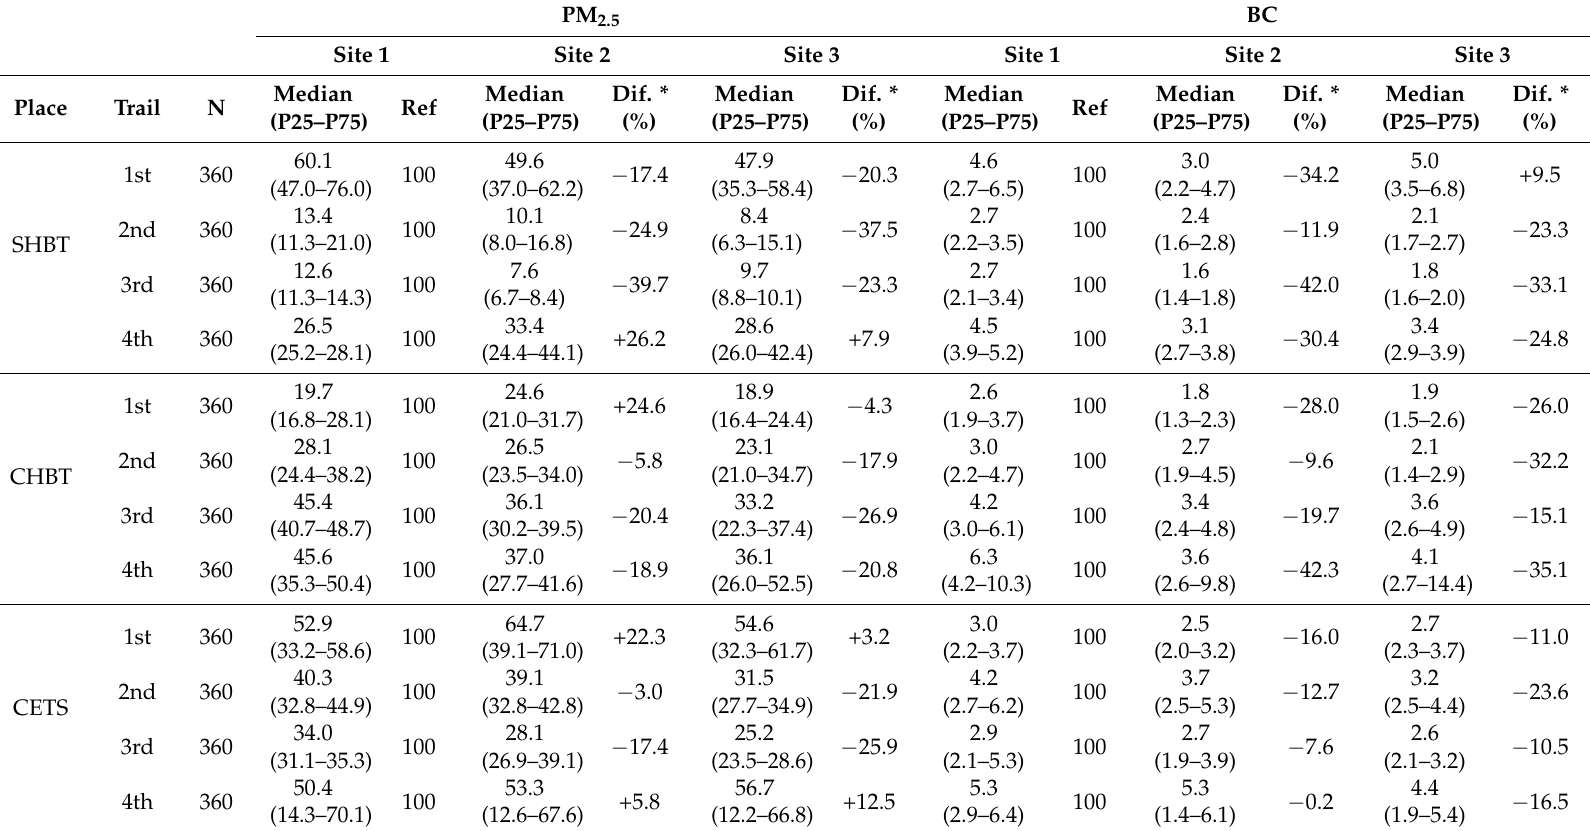
Table 1. Distributions of PM 2.5 and black carbon (BC) concentrations (Median (IQR)) of simultaneous measurement for three sites according to sampling place and sampling day (1st to 4th